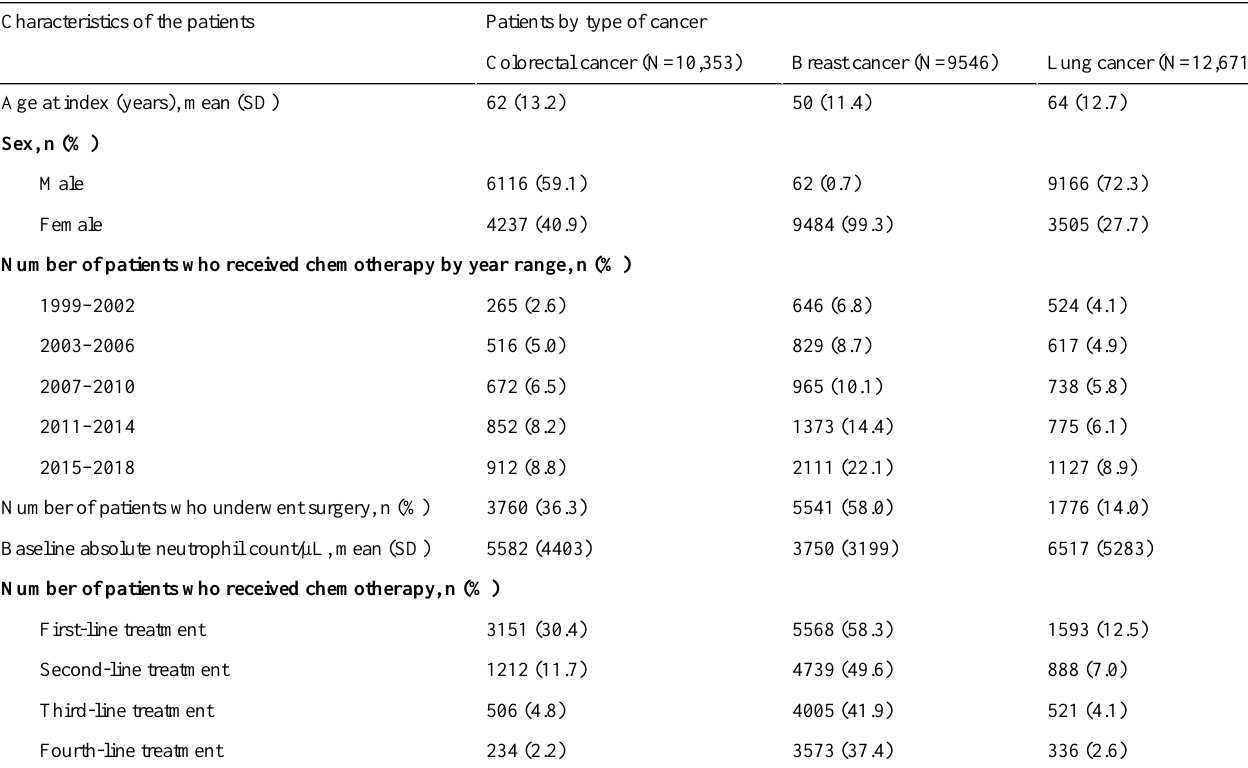
Table 1. Characteristics of patients with colorectal, breast, and lung cancer in the Ajou University School of Medicine database.